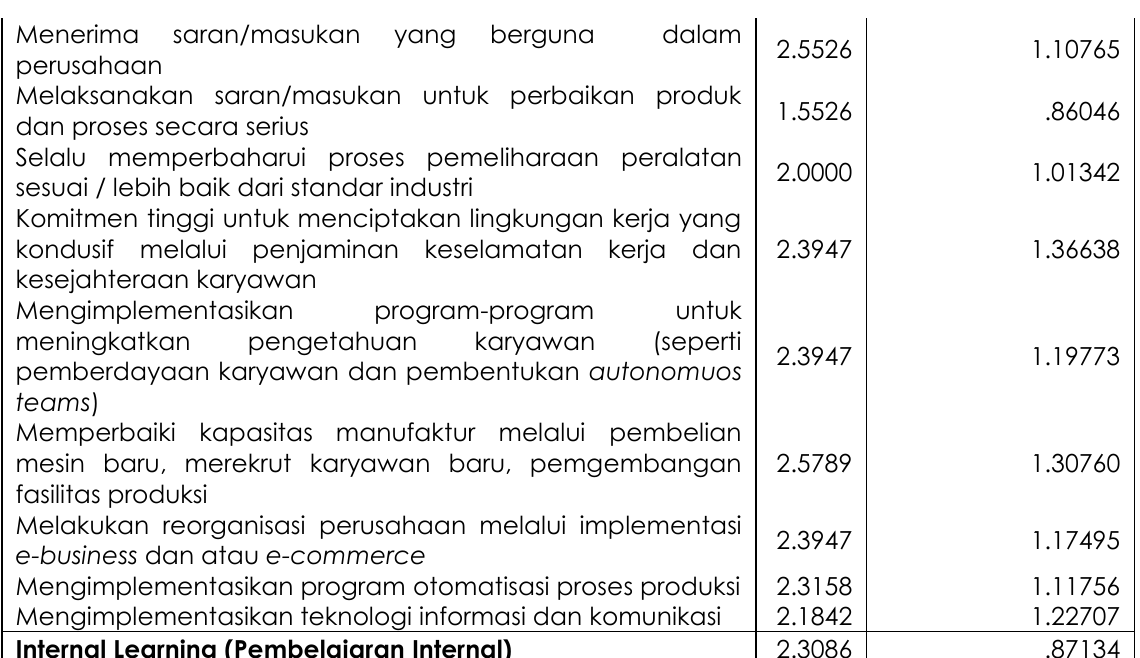
Table 5: Tingkat Pembelajaran Eksternal (External Learning)